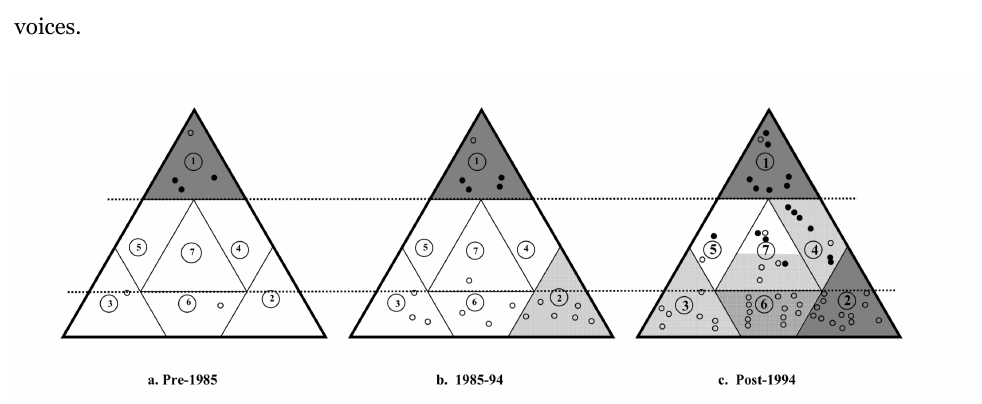
Figure 2: Evolution of the Governance Triangle. (Abbott & Snidal, 2010). Reproduced with permission from the